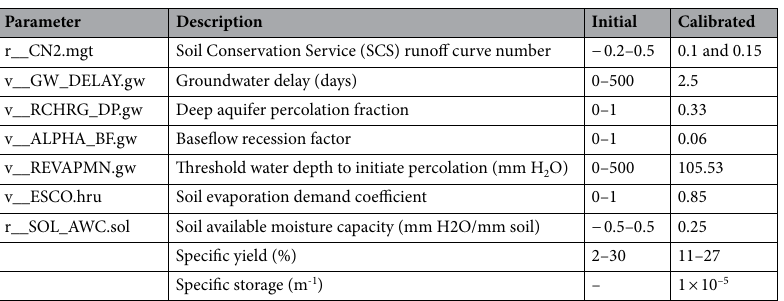
Table 2. Initial range, calibrated value, and definition of parameters used in the calibration and validation processes. r__default SWAT parameter is multiplied by (1 + optimized value); v__ replaced the default value.